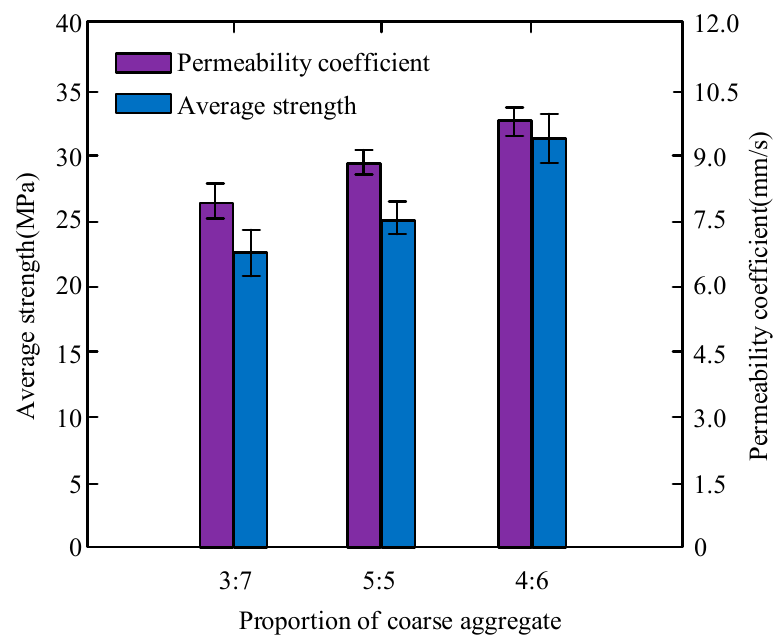
Figure 5. Performance comparison of specimens with different properties of coarse aggregate and coarse aggregate.